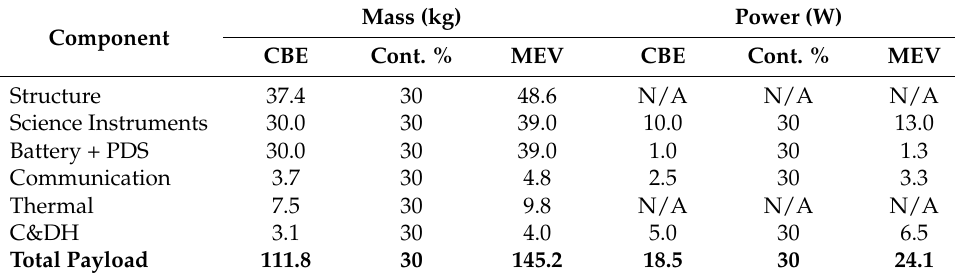
Table 2. VAIHL Mission gondola mass and power breakdown.